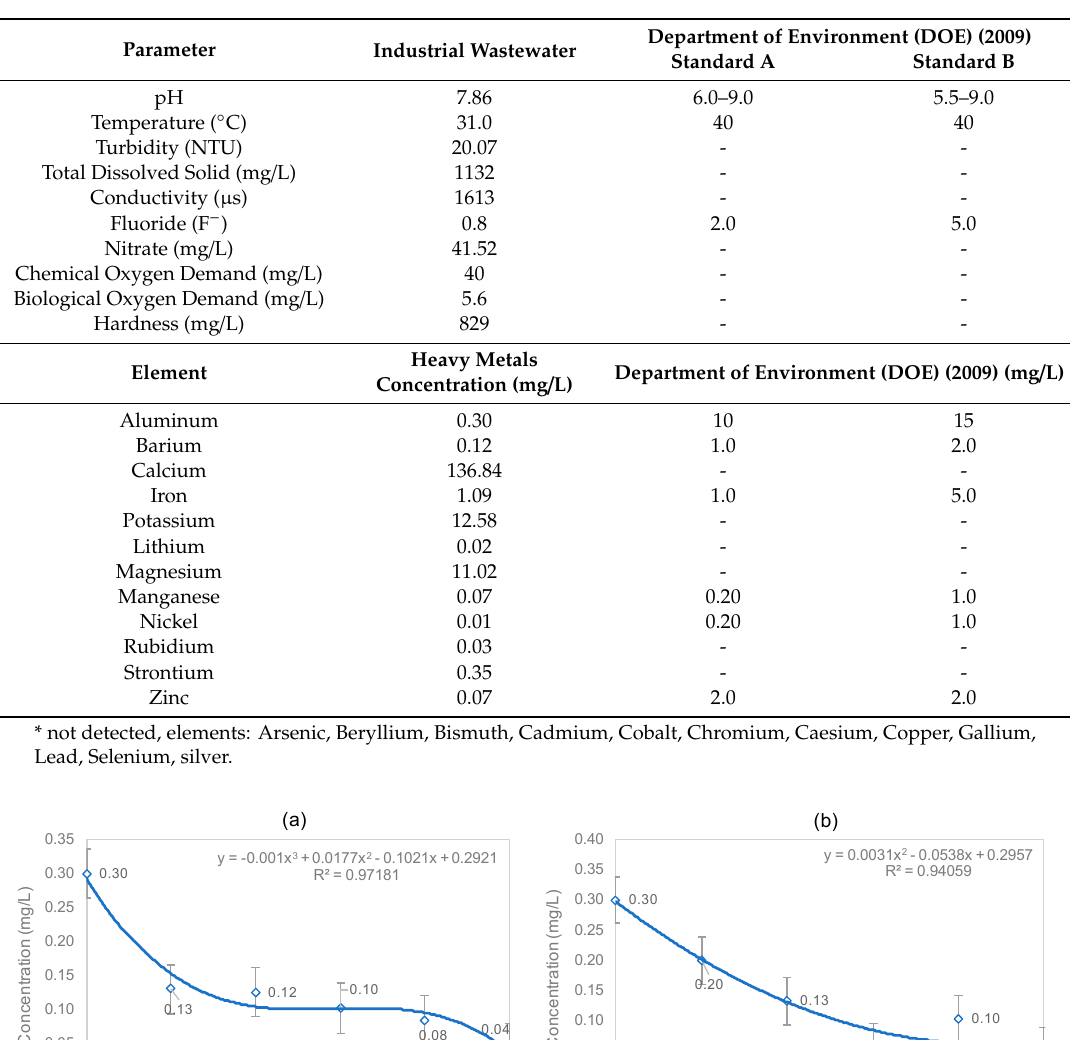
Table 1. Analysis of the heavy metal content from industrial wastewater.